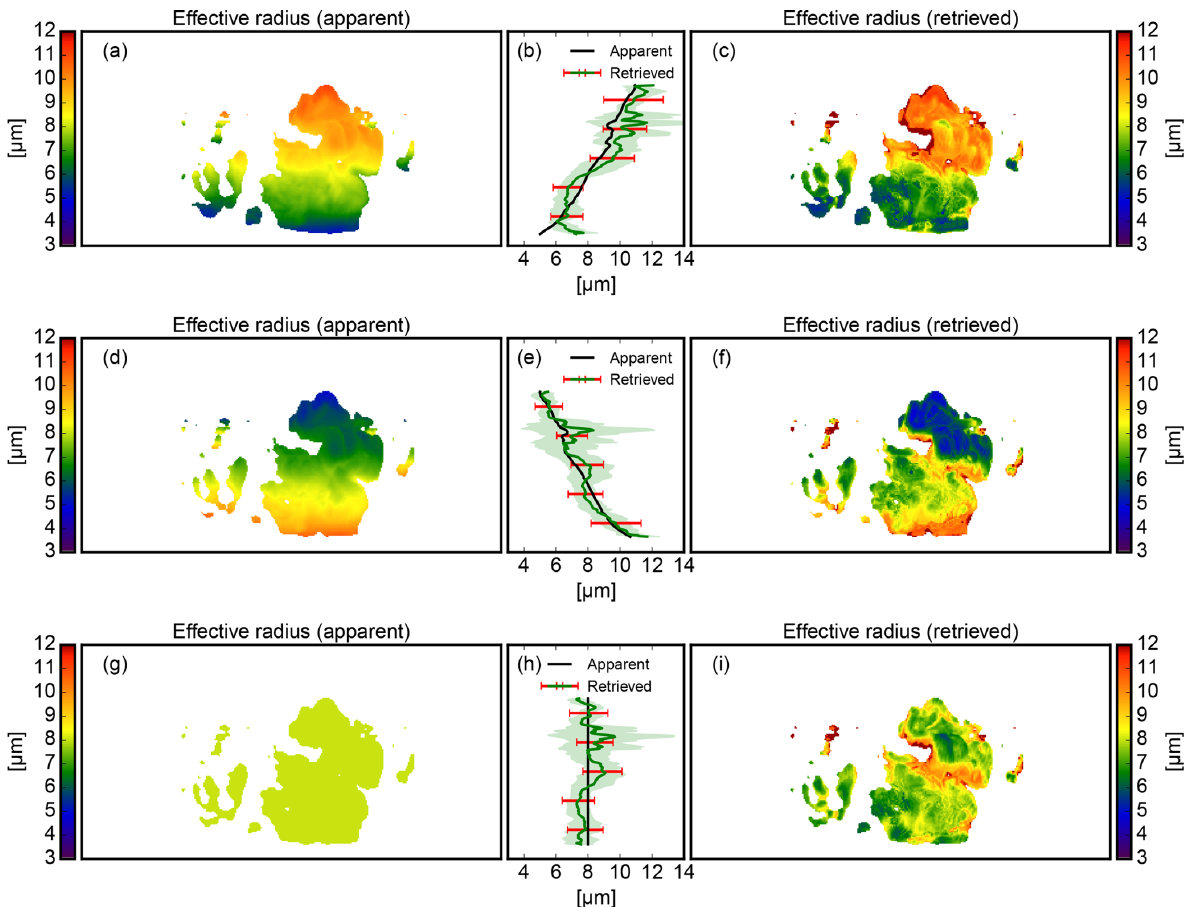
Figure 20. Retrieval test between the apparent effective radius (a, d, g) and the retrieved mean effective radius (c, f, i) for the normal (a–c) , flipped (d–f) , and fixed (g–i) effective radius profile. (a) Apparent effective radius (cid:104) r eff (cid:105) app for the normal profile, (b) mean and standard deviation of the apparent (black) and retrieved (green) vertical effective radius profile (normal) with the mean statistical retrieval uncertainty (red error bars). (c) Retrieved mean effective radius for the normal microphysical profile, (d, e, f) As in (a–c) but for the flipped microphysical profile. (g, h, i) As in (a–c) but for the fixed microphysical profile.